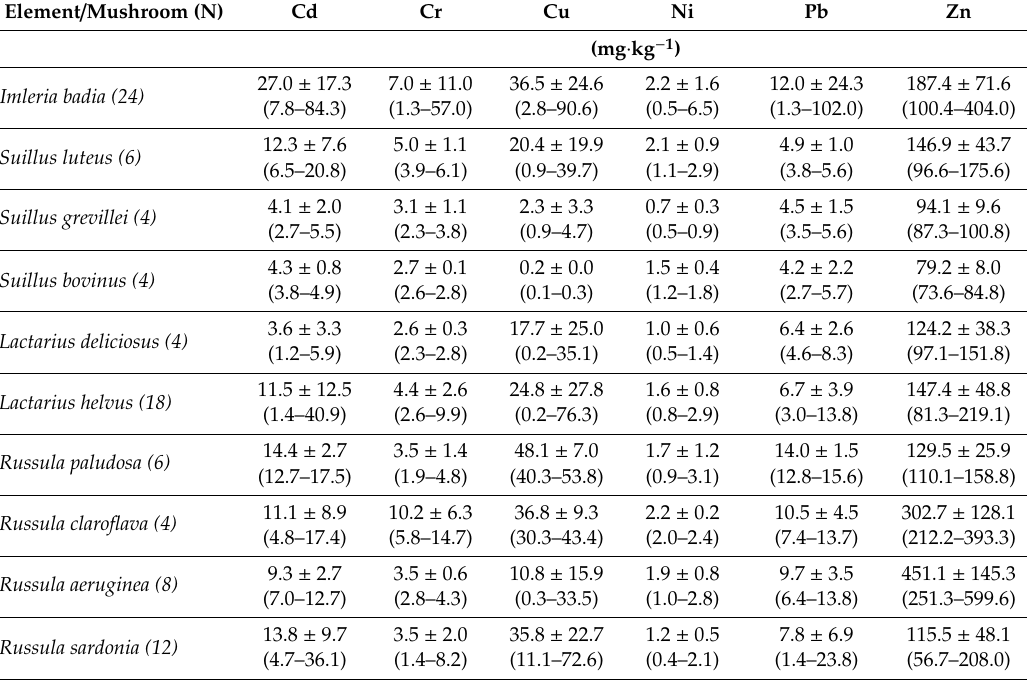
Table 3. Content of heavy metals in the mushrooms of the study area.